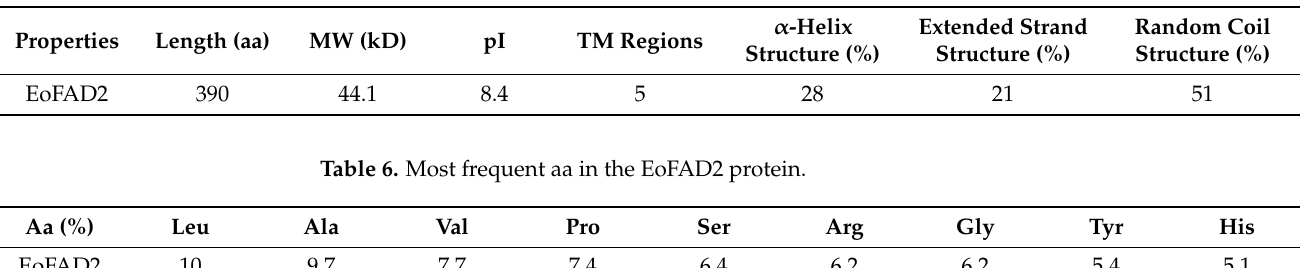
Table 5. Peptidic composition and physico-chemical features of the EoFAD2 protein.